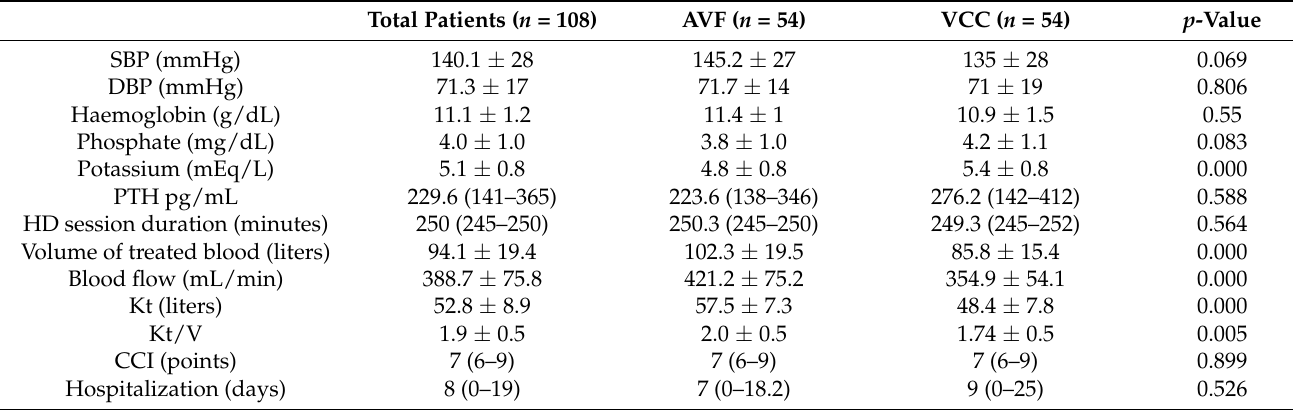
Table 3. Comparison between patients with AVF and VCC of the analytical values studied, dialysis efficacy variables, comorbidity and days of hospitalization.